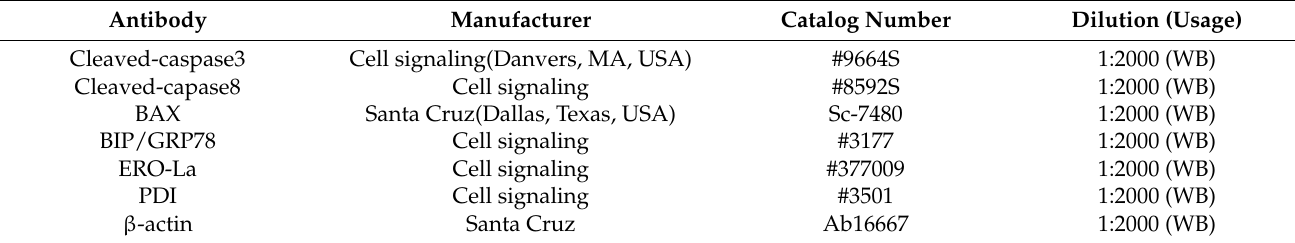
Table 2. List of primary antibodies